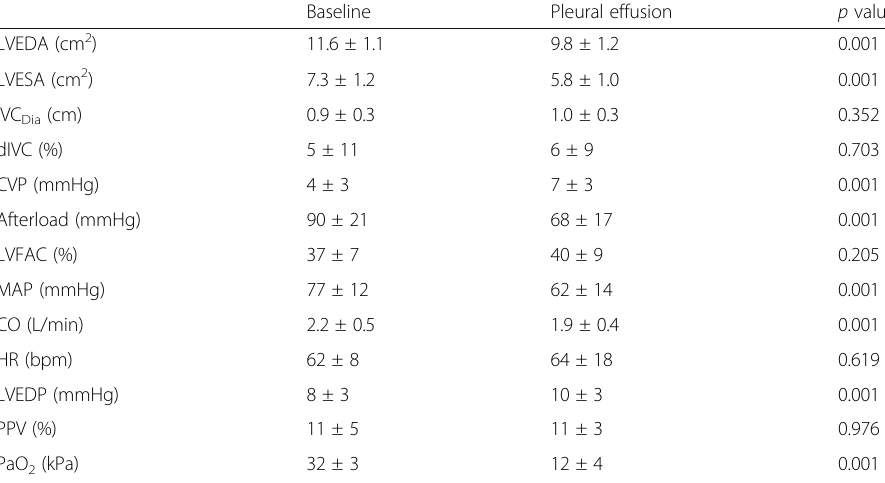
Table 1 Pleural effusion and haemodynamic